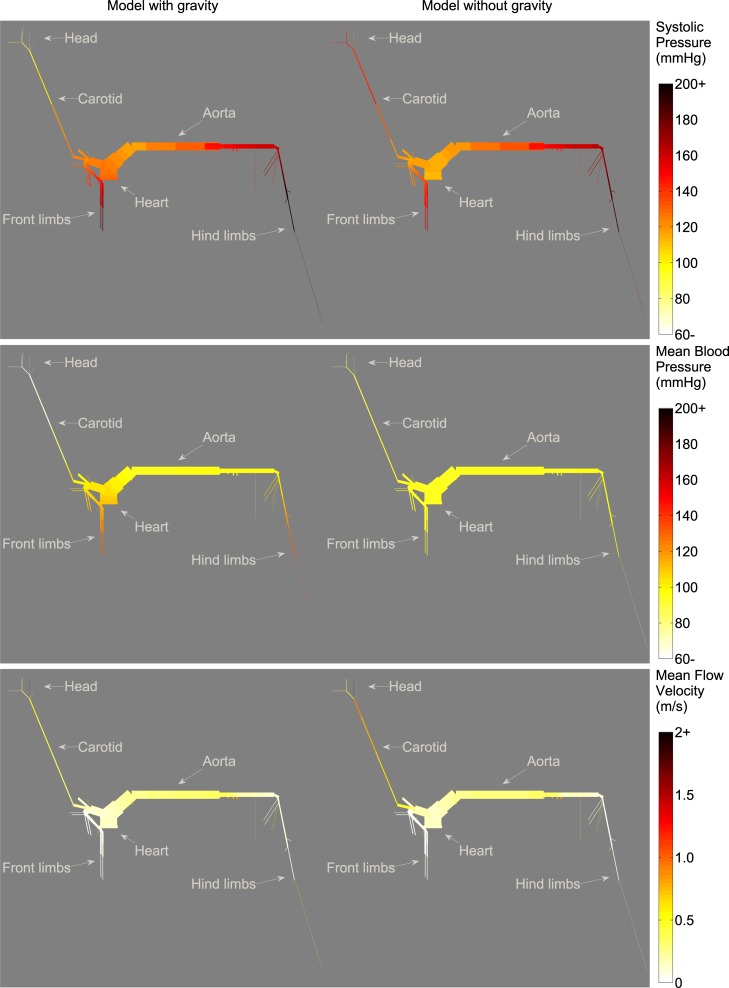
Distribution of systolic pressure, mean blood pressure and mean flow velocity over the complete arterial tree, comparing the model including gravity with the model neglecting gravity.Lower and higher values are indicated with colours varying from light to dark tones, respectively.